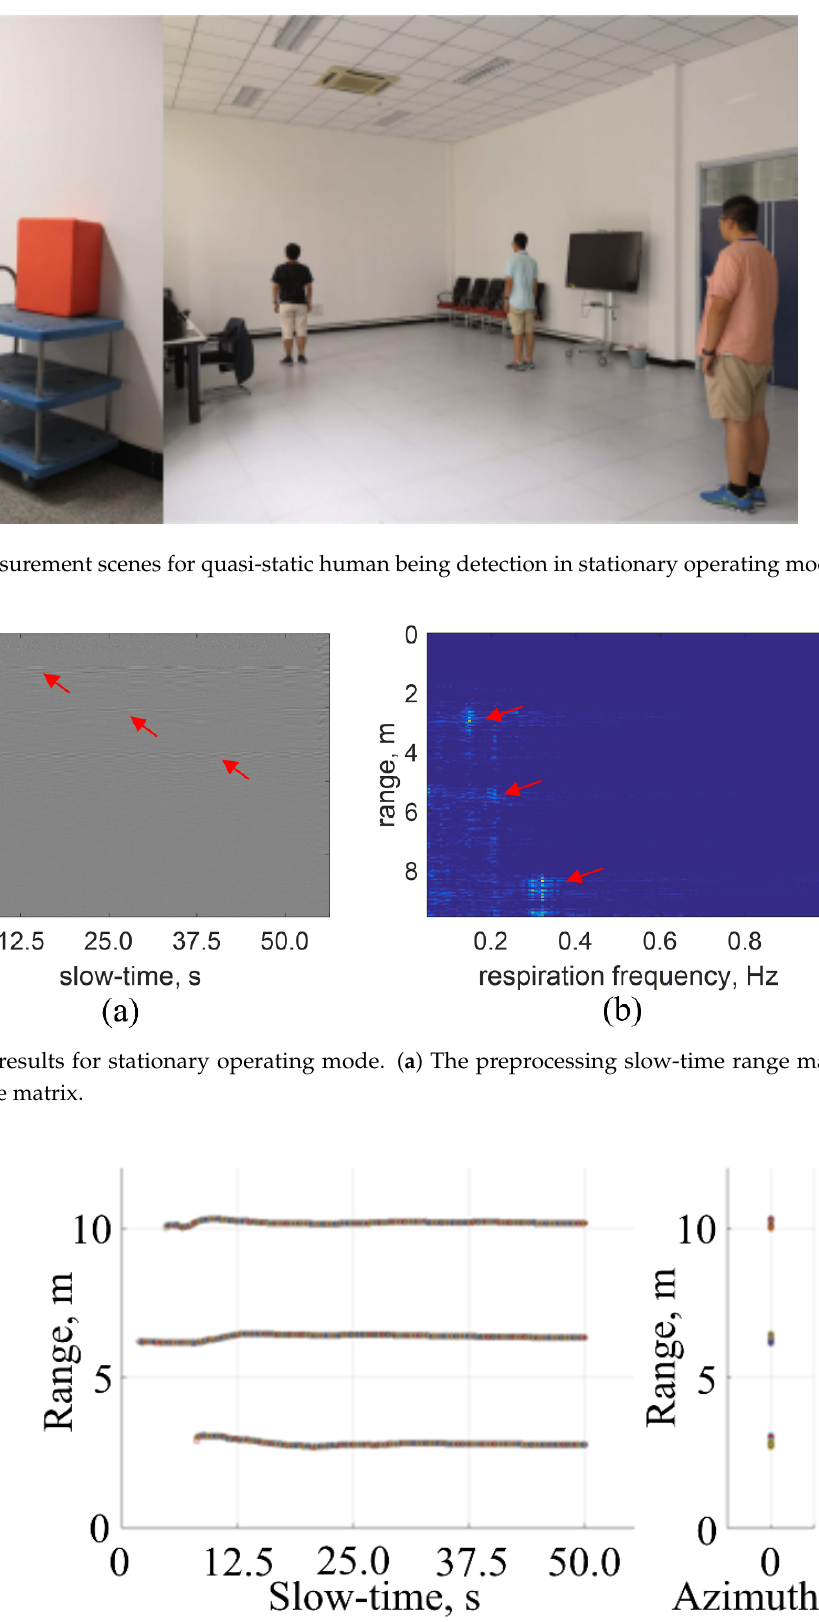
Figure 8. Experimental detection and classification result for stationary operating mode.